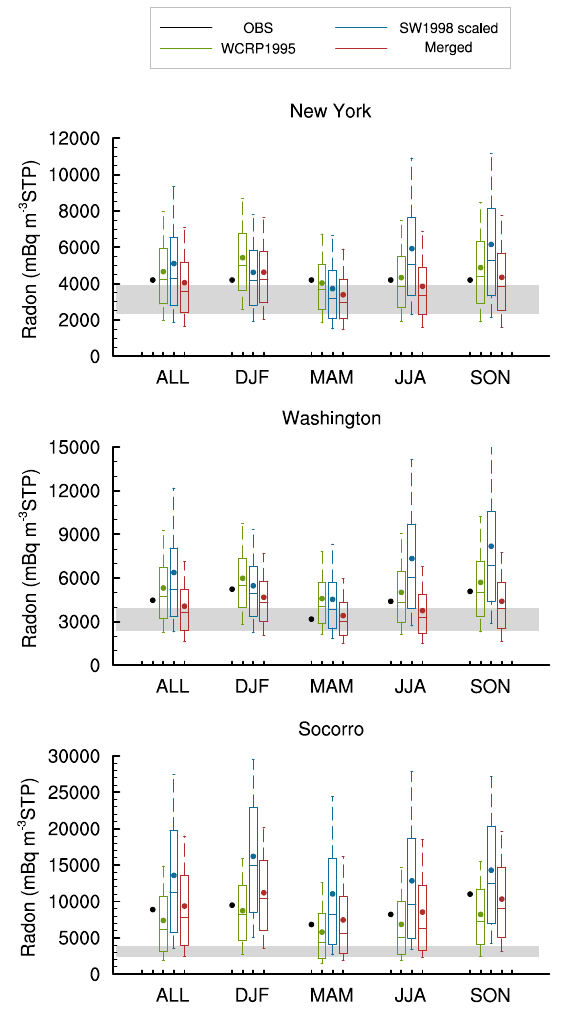
Fig. 9. Same as Fig. 7 but for three sites in the United